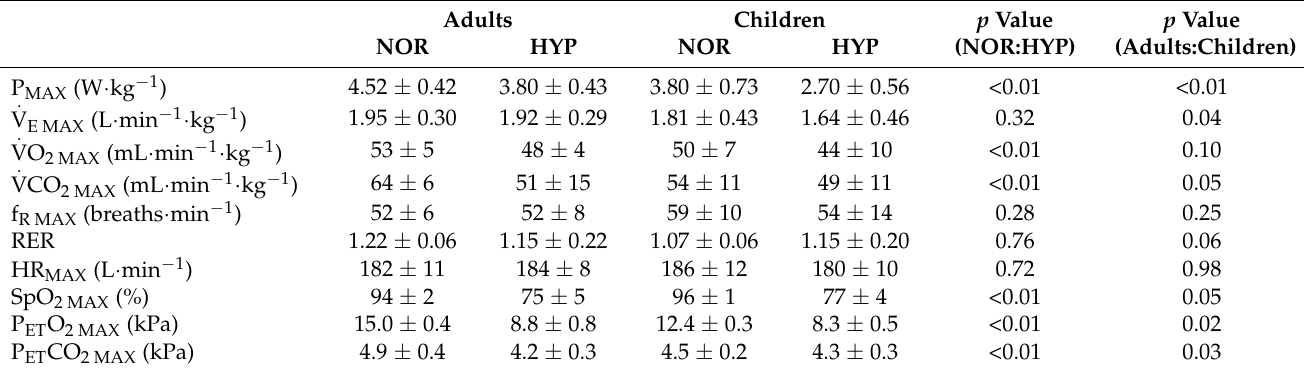
Table 2. Cardiorespiratory and gas exchange values in adults and children at maximal intensities during normoxic (NOR) and hypoxic (HYP) exercise testing sessions. Adults Children p Value p Value NOR HYP NOR HYP (NOR:HYP) (Adults:Children)